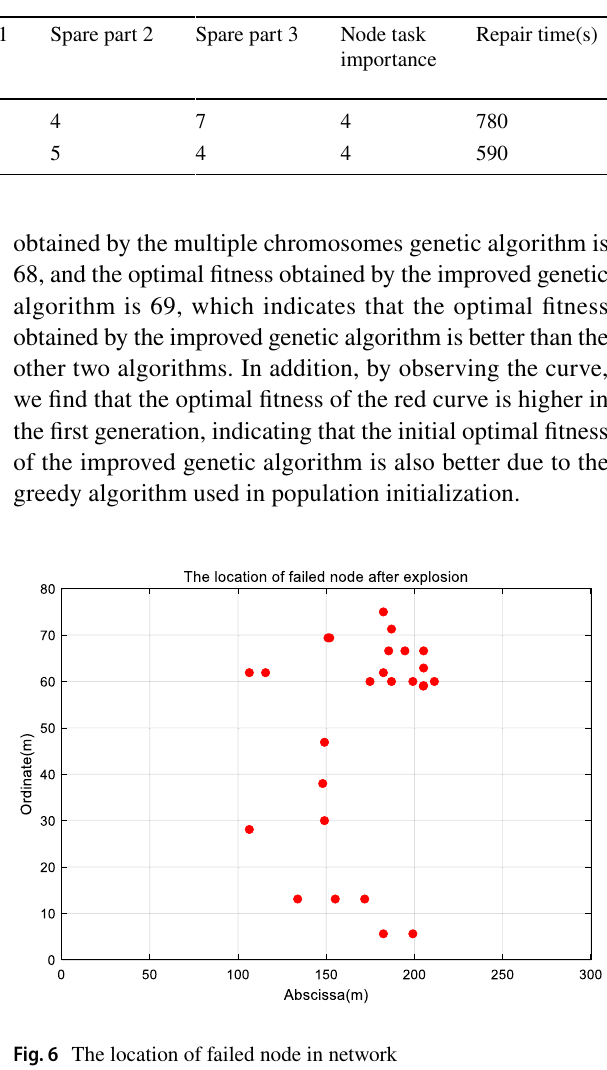
Fig. 6 The location of failed node in